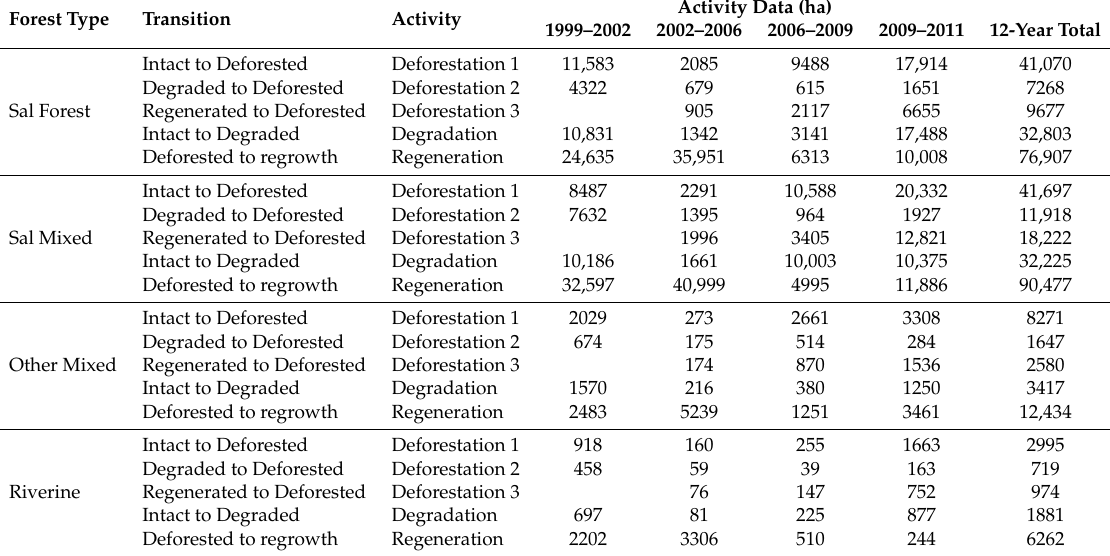
Table 5. Activity data for different forest types between 1999 and